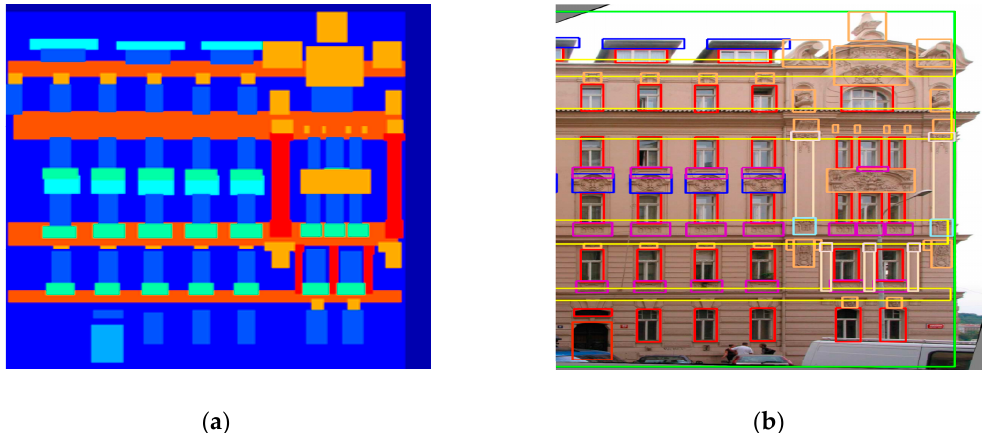
Figure 1. Example of the label to architectural photos. ( a ) shows an input labeled image. ( b ) shows marked objects in a ground-truth